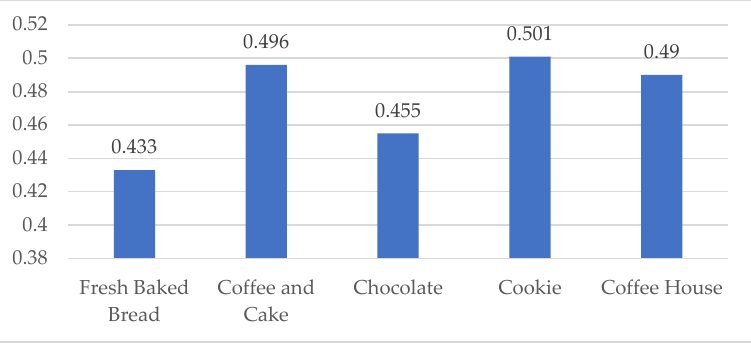
Figure 11. Score of frustration in measuring the effect of aromas on emotional response.